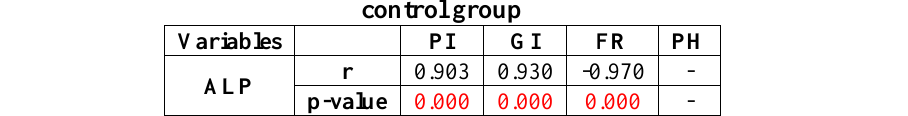
Table 5: Pearson’s Correlation Coefficient (r) between ALP and PL, GI, FR and PH of